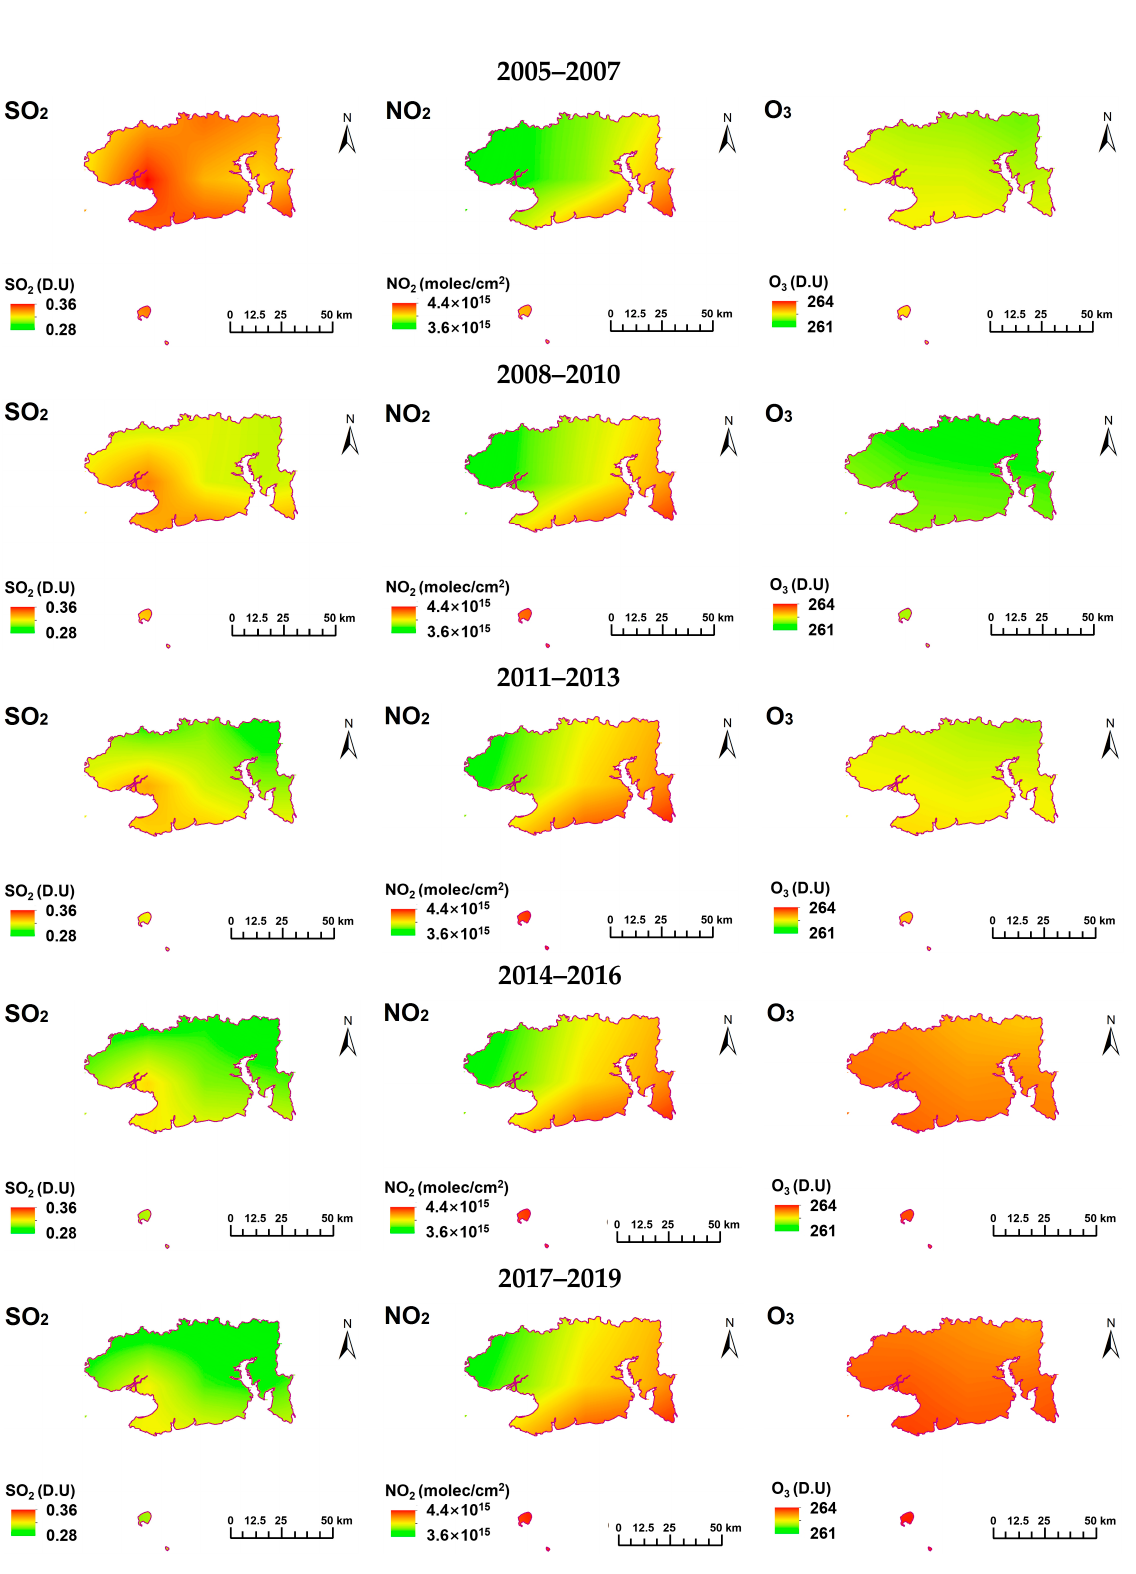
Figure 2. Spatial distribution of averaged VCD NO 2 , SO 2 and O 3 over 15 years from 2005 to 2019 in Beihai.